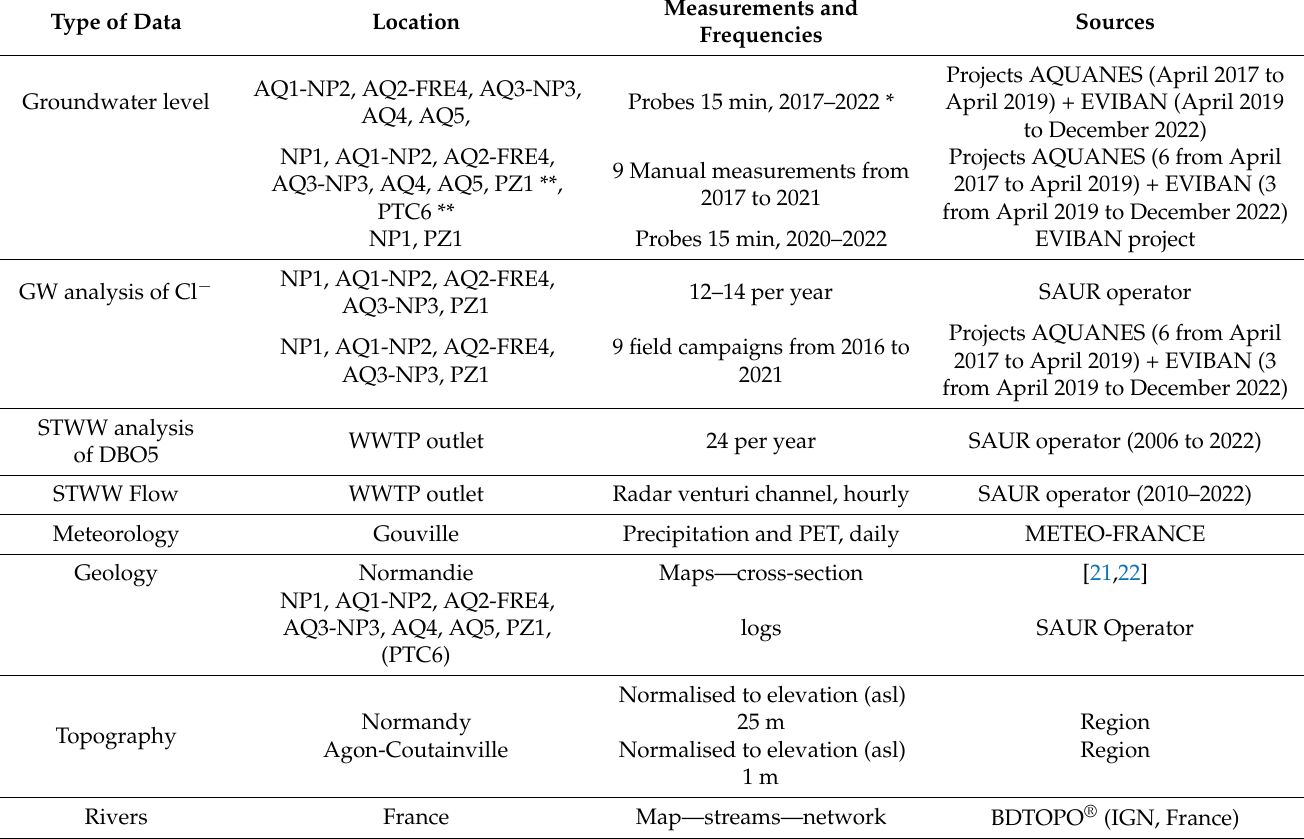
Table 1. Available and acquired data for the Agon-Coutainville SAT